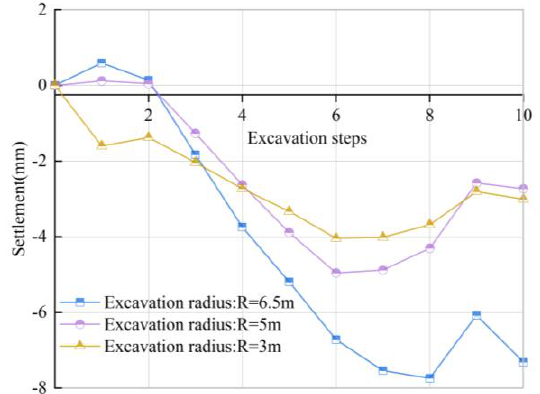
Figure 16. Influence of excavation radius on the longitudinal deformation of the ground surface.